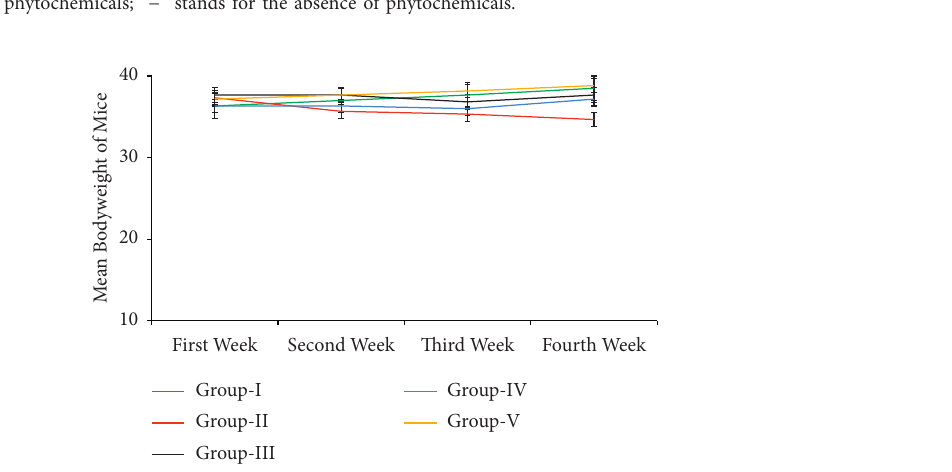
Figure 1: The mean bodyweight of the Swiss albino mice from the first week to the fourth week (the results are expressed as mean ± SE). Table 2: Effect of corm of Ensete ventricosum (Welw.) Cheesman extract on liver enzyme parameters and serum total bilirubin (TBIL) in isoniazid and rifampicin challenged mice.